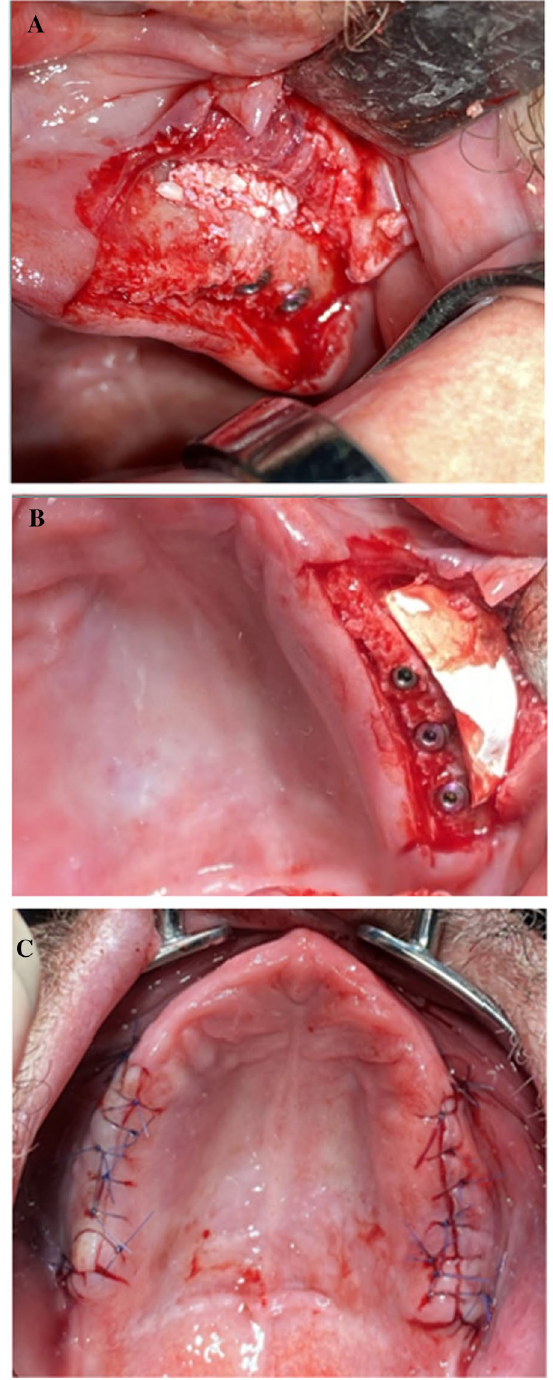
Fig. 2 Intraoperative clinical situation during augmentation with simultaneous implantation. A Intraoperative situation after augmentation with additional application of bovine bone particles and implantation with the lateral window technique. B Intraoperative situation after additional application of a resilient resorbable collagen barrier membrane (OSSIX Plus). C Palatal image immediately after surgery shows tension‑free